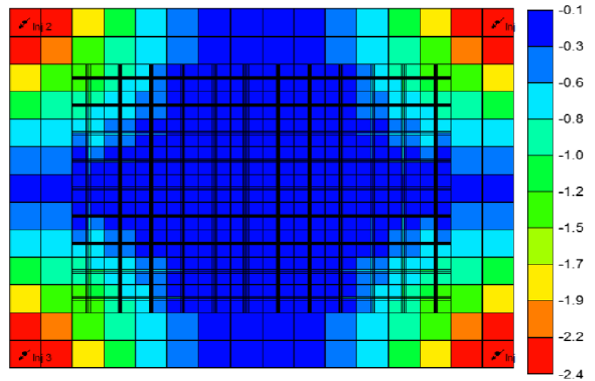
Fig. 8 Oil saturation distribution under dynamic condition after the production for 14